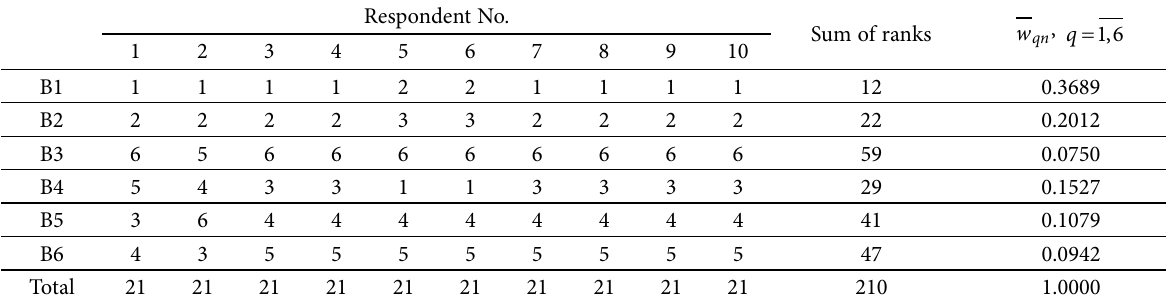
Table 10. Ranking of the B criteria sub-sets (B1…B6) in the respondent questionnaires Respondent No.